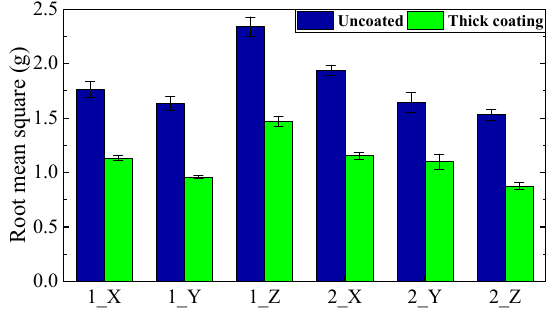
Figure 9. Root mean square value and standard deviation of vibration acceleration.